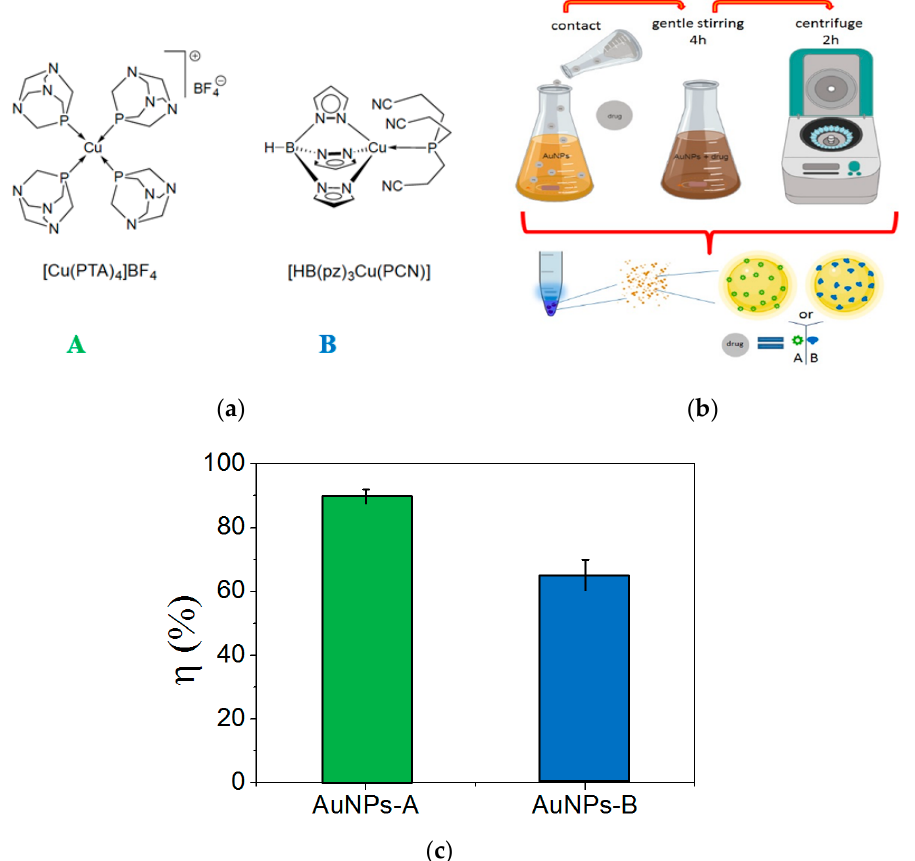
Figure 2. ( a ) Chemical structures of anticancer Cu(I) complexes used in this study; ( b ) sketch of loading protocol to obtain AuNPs-A and AuNPs-B conjugates; ( c ) loading efficiency η (%) for AuNPs-A (in green, η (%) = 90 ± 4 %) and AuNPs-B (in blue, η (%) = 65 ± 10 %).